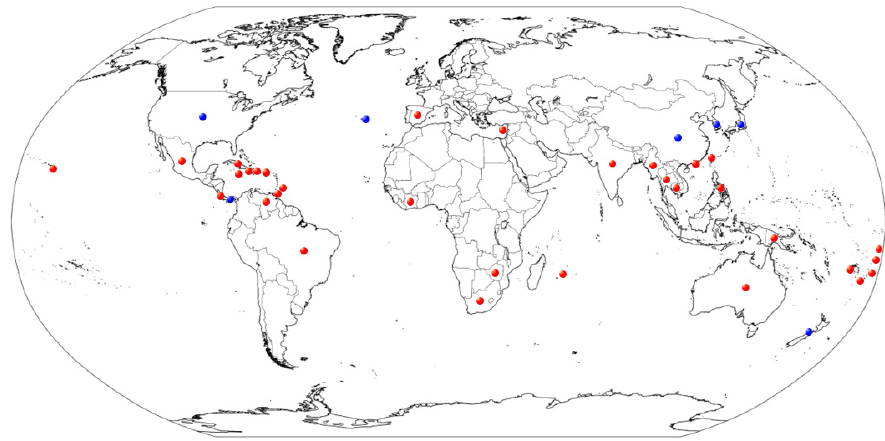
Figure 2. A global geographic distribution of D. citri associated with Citrus -host plant and available on SMML database. Blue colored dots indicate the availability of the accession numbers in the NCBI database, while red colored dots indicate the non-availability.